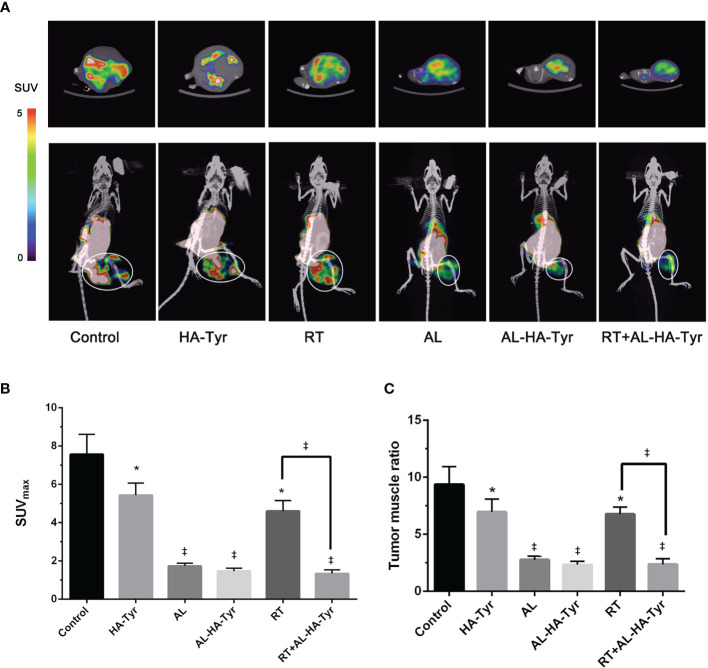
Hypoxic image of 18F-FMISO PET/CT after treatment, maximum standard uptake value (SUVmax) of ROI, and tumor muscle ratio (T/M) in each group. (A) Representative 18F-FMISO PET/CT MIP fusion image (rainbow color scale). The upper image is a cross section of the tumor; the lower image is the coronal surface of the tumor. The ellipses in the images are the regions of interest (ROIs) in the tumor target. (B) SUVmax of ROI in each group. (C) T/M in each group. (n = 3) *P < 0.05, and ‡P < 0.001, control vs. hyaluronic acid-tyramine (HA-Tyr), anlotinib (AL), anlotinib hydrogel (AL-HA-Tyr), radiotherapy (RT), and AL-HA-Tyr+ RT, respectively; RT vs. AL-HA-Tyr+ RT.